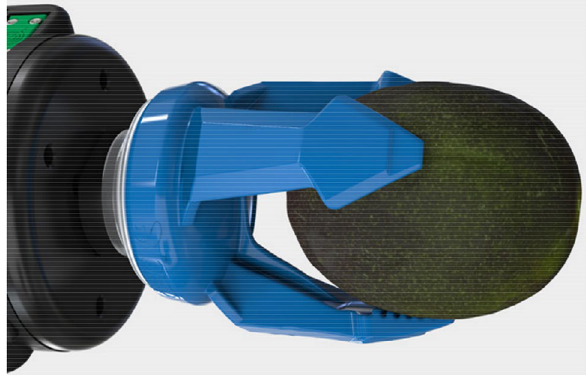
Fig. 2 Soft industrial gripper based on the principle of a pneumatic muscle